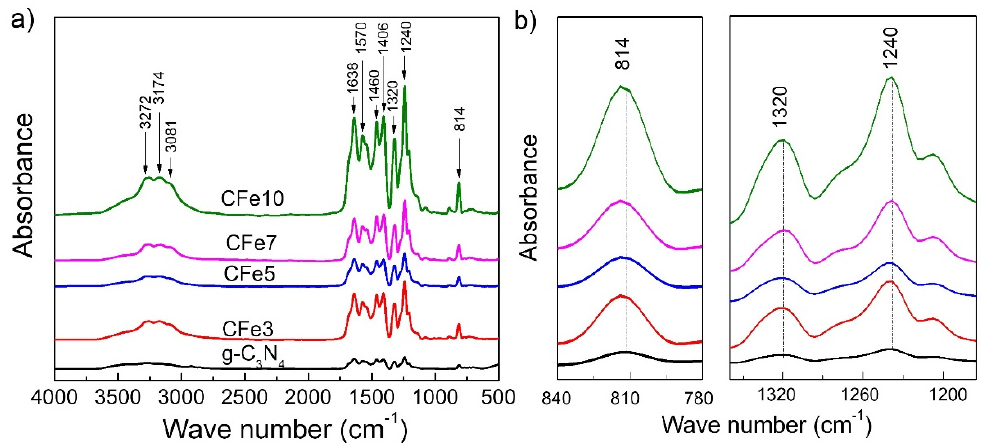
Figure 3. ( a ) Fourier-transform infrared (FT-IR) spectra of Fe-doped g-C 3 N 4 nanosheets with different Fe concentrations and ( b ) The shift of FTIR peak position.